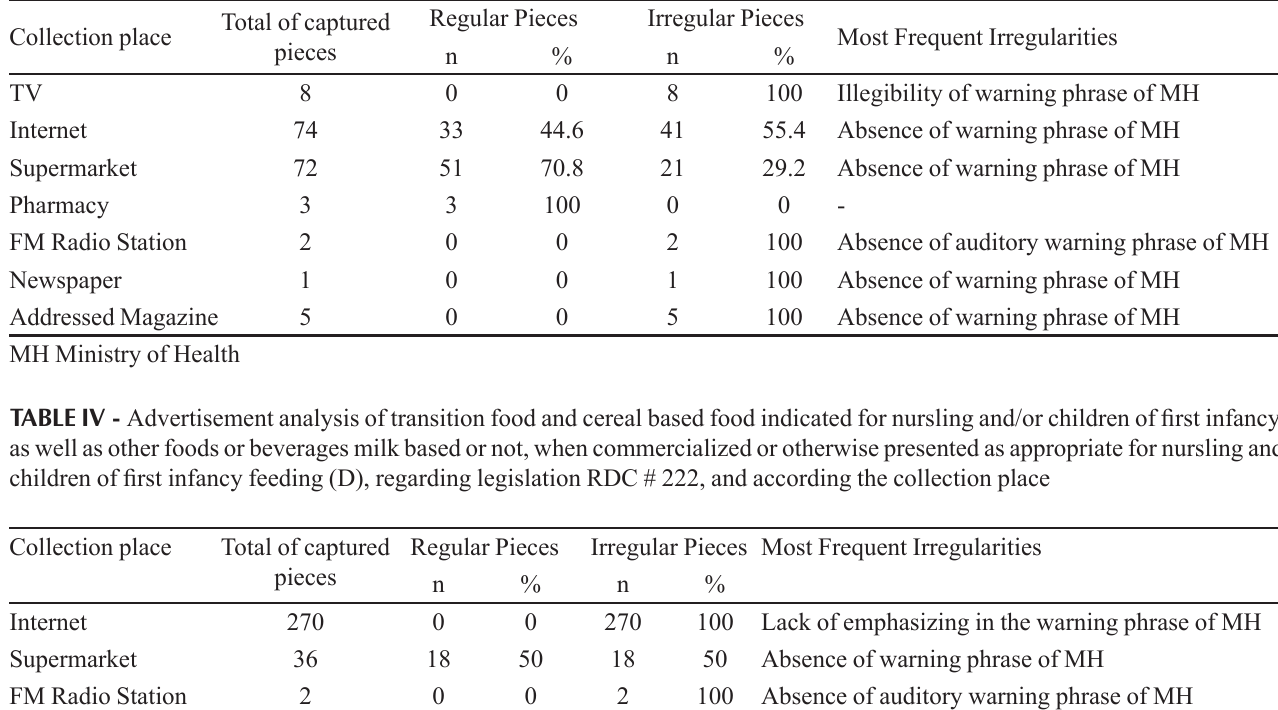
TABLE III - Analysis of fluid milks, modified powdered milk, milks from varied animal species, and products of plant origin with the same purpose (C), respecting the legislation, according to collection place Collection place